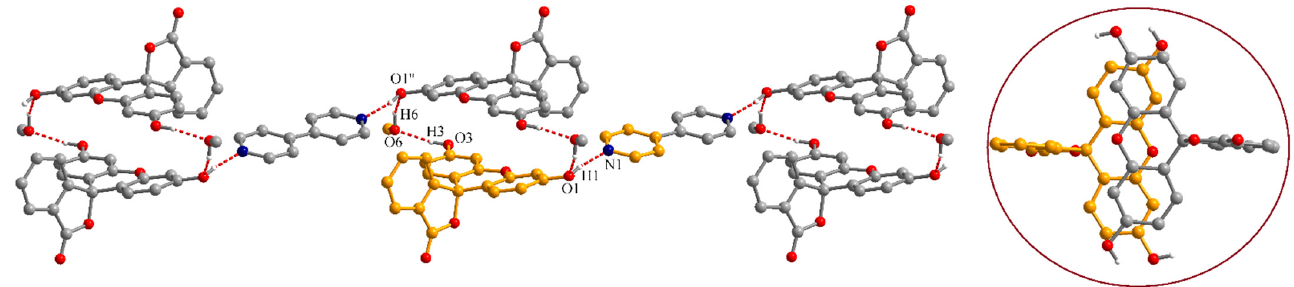
Figure 5. Perspective view of the 1D supramolecular array formed through hydrogen interactions in crystal 2 . The inset shows a detail of the π−π interactions established within the supramolecular dimers. Symmetry code: “= 1 − x, 2 − y, 1 − z.